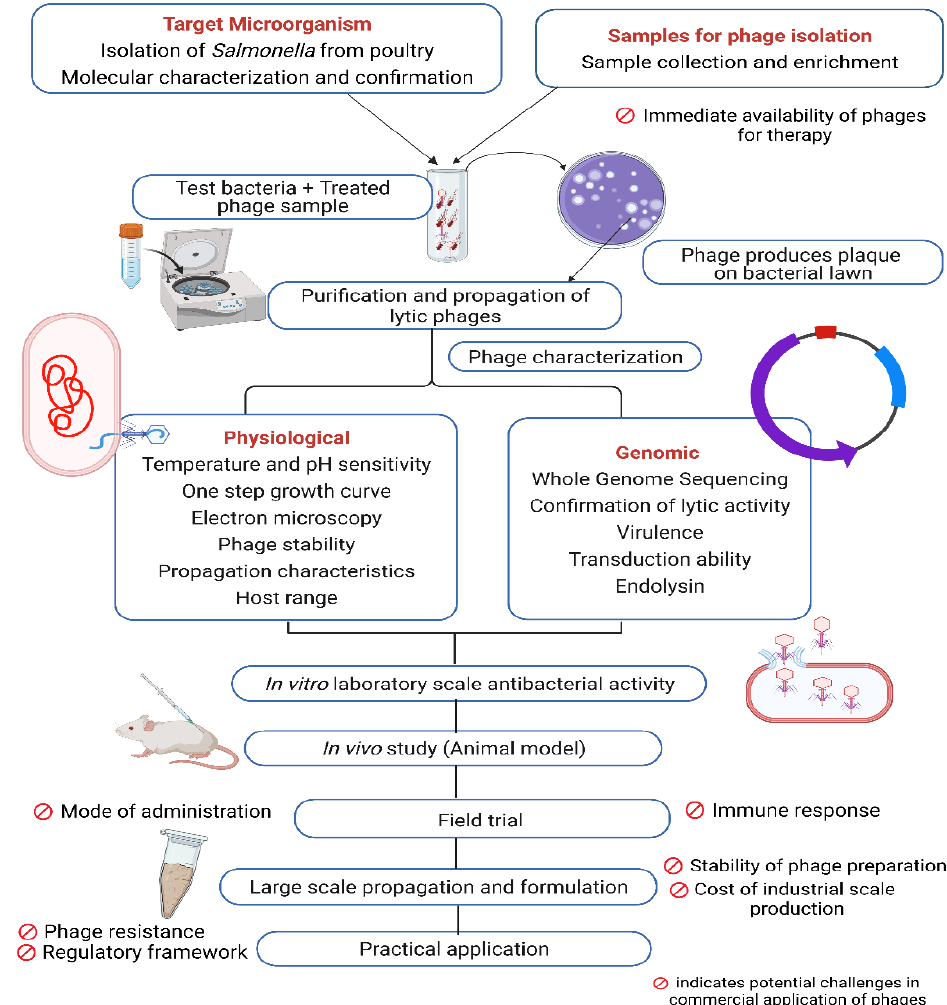
Figure 1. Steps in phage application process with potential challenges in poultry industry.